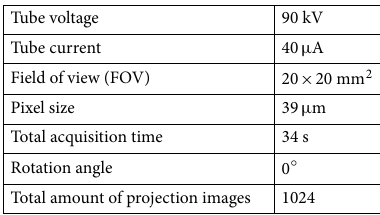
Table 2. Parameter for X-ray based lung function